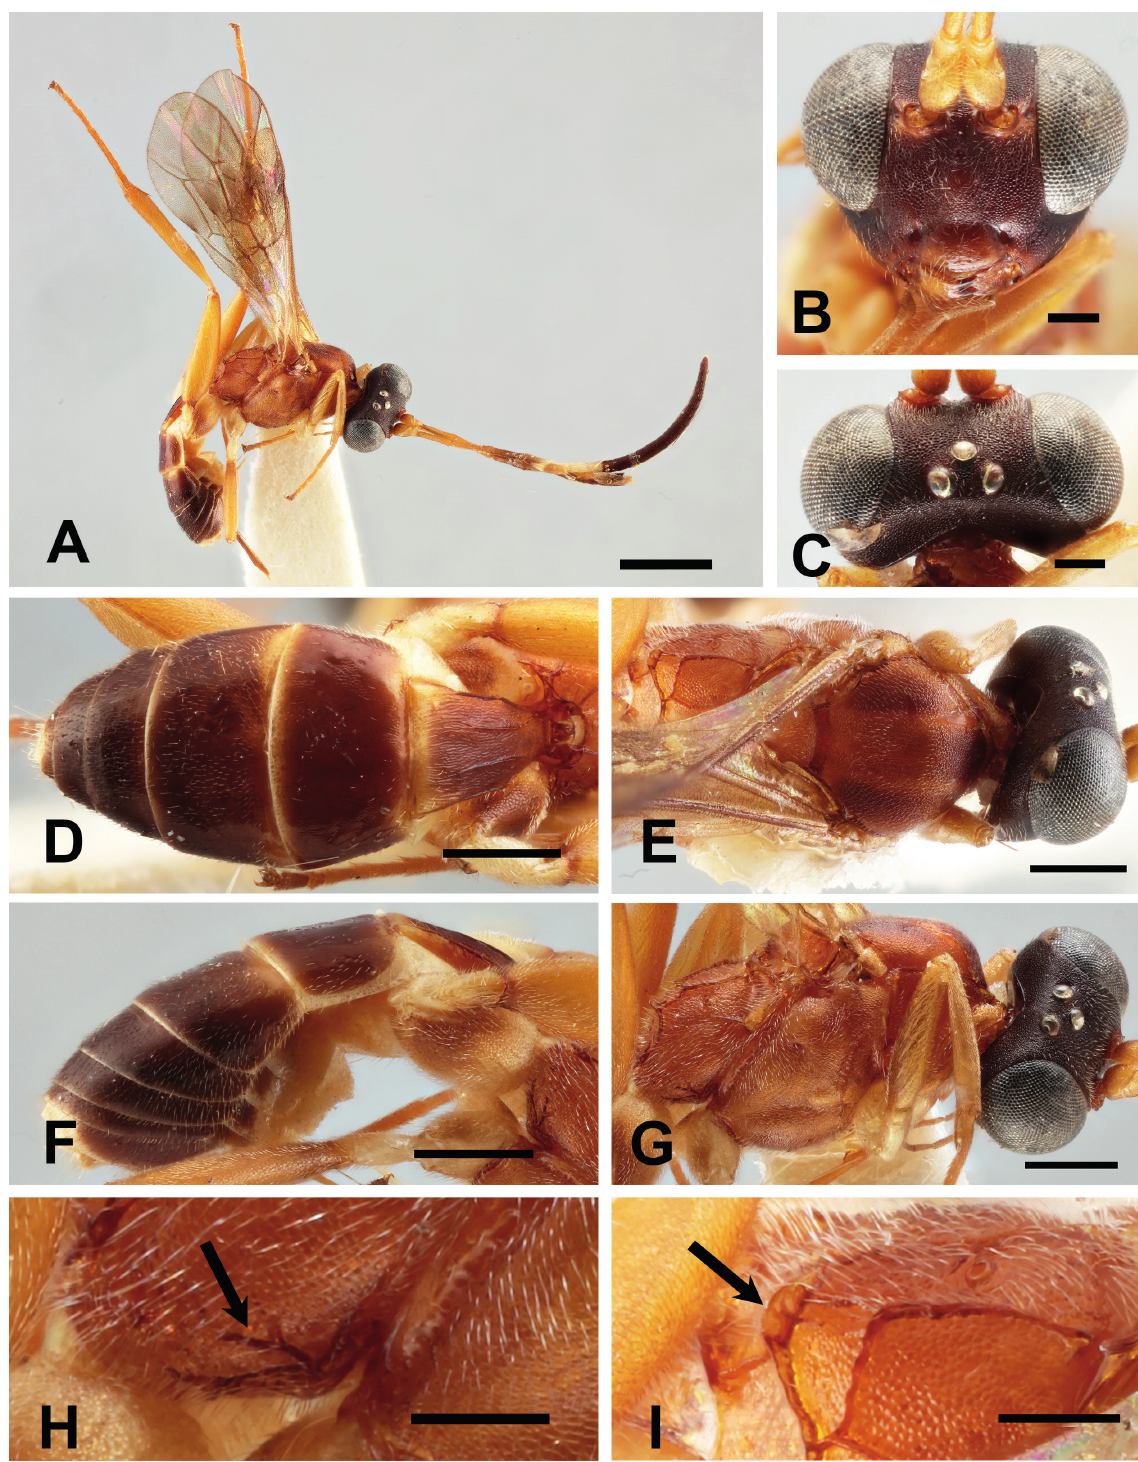
Fig. 8. Morphology of Handaoia urceus sp. nov., holotype, ♀ (NMHUK). A . Habitus, lateral view. B . Head, front view. C . Head, dorsal view. D . Metasoma, dorsal view. E . Head and mesosoma, dorsal view. F . Metasoma, lateral view. G . Head and mesosoma, dorsolateral view. H . Metapleuron (arrow: juxtacoxal carina). I . Propodeum (arrow: propodeal apophysis). Scale bars: A, D–G = 0.5 mm; B–C, H–I = 0.2